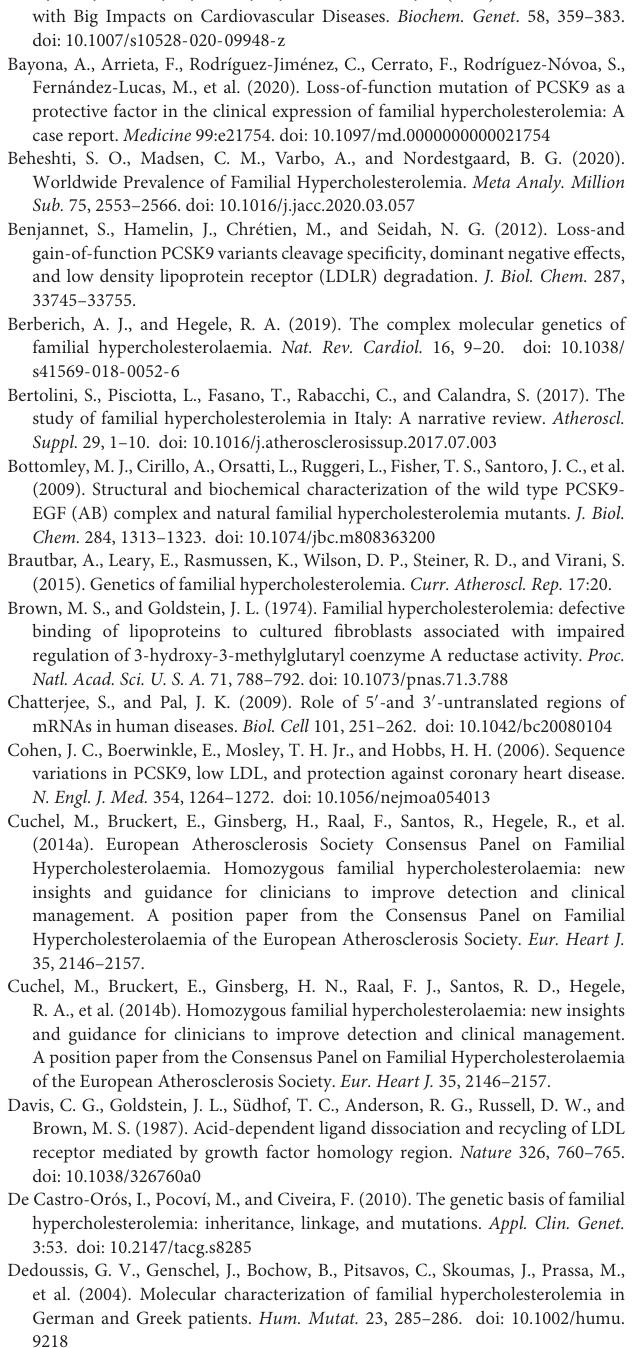
Supplementary Table 1 | The sequences of all designed oligonucleotides utilized in this study to perform the PCRs and Sanger sequencing. Supplementary Table 2 | All nucleotide variations of LDLR gene found in this study.